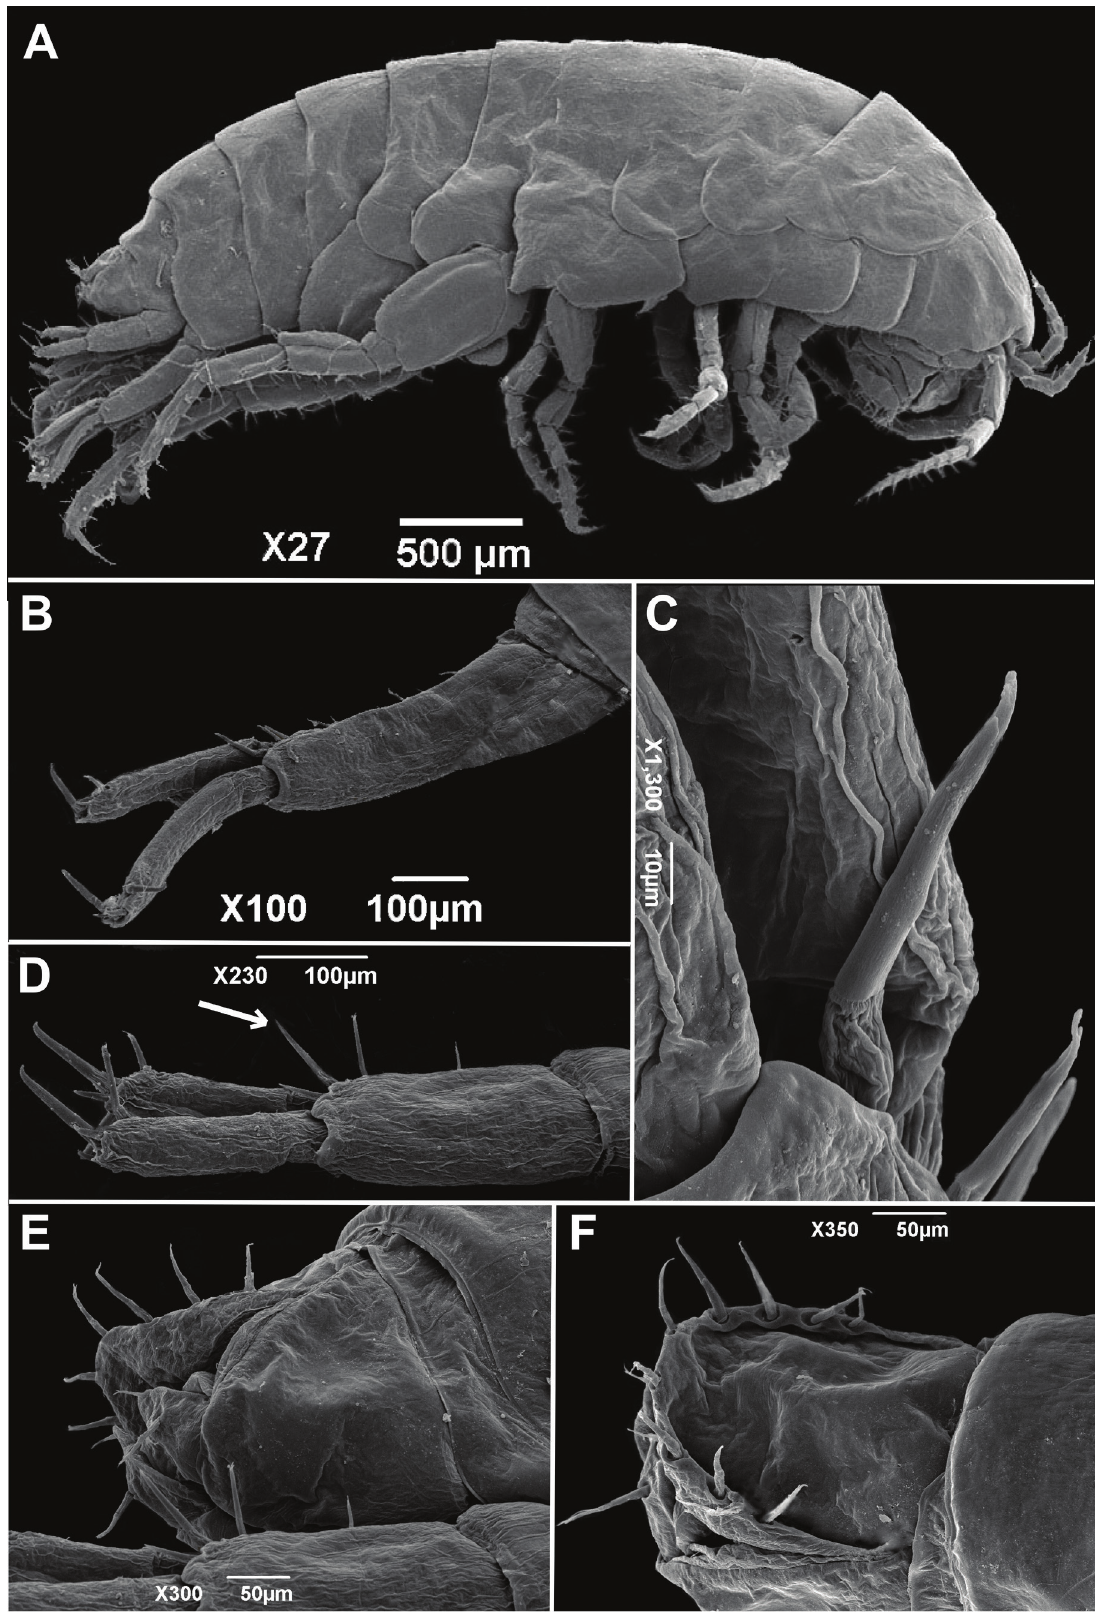
Figure 3. SEM photomicrographs of Talitroides alluaudi (Chevreux, 1896). A) Female MNRJ 9717: Habitus; B – F) Female, MNRJ 9717: B) Uropod 1, C) Distolateral robust seta of uropod 1 with simple apex, D) Uropod 2 (arrow indicate the larger middle postero-distal setae), E) Uropod 3, F)